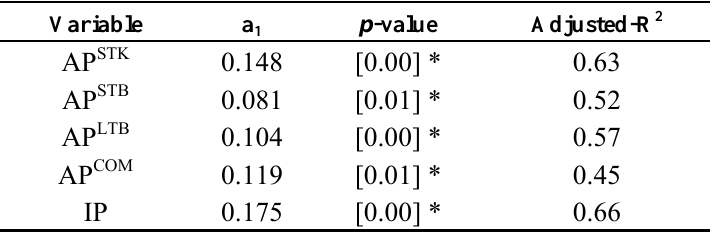
Table 3. FMOLS (fully-modified ordinary least squares) long-run